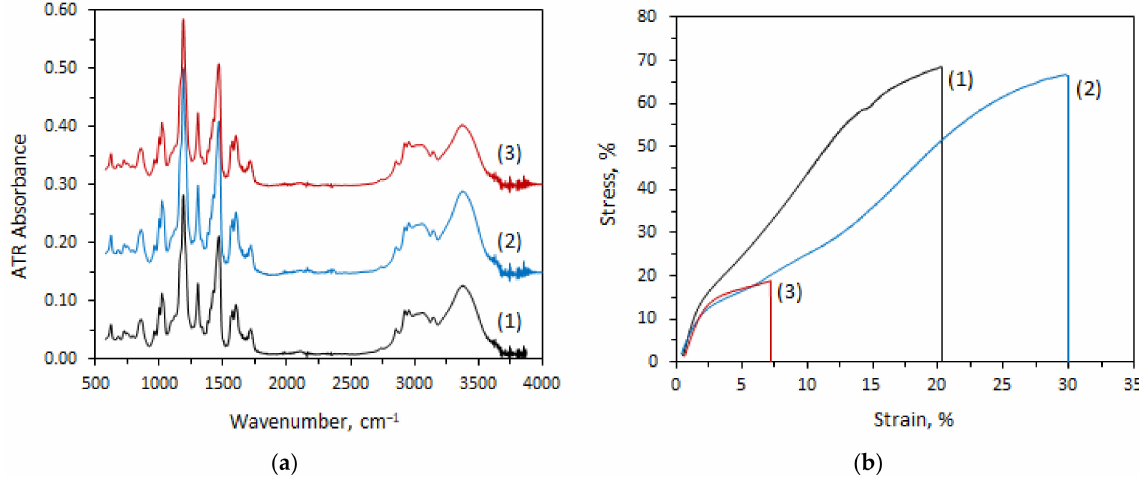
Figure 3. Fourier transform infrared spectroscopy (FT-IR) spectra ( a ) and ( b ) stress-strain curves for membranes (1) before use (initial state) and after stress-tests at 25 ◦ C (2) and 60 ◦ C (3) (in the air-dry state, Cl −